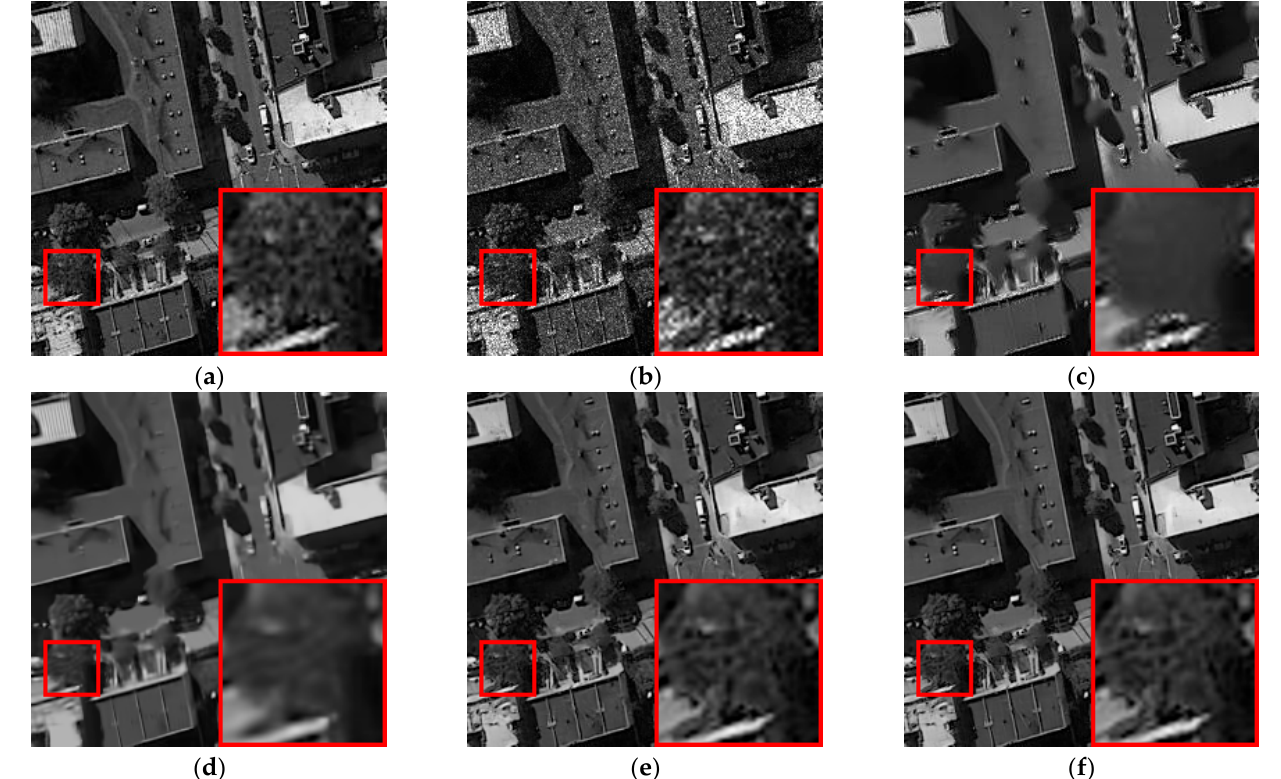
Figure 9. Filtered images of different methods for medium residential test image contaminated by four-look speckle. ( a ) Original image, ( b ) noisy image, ( c ) PPB, ( d ) SAR-BM3D, ( e ) ID-CNN, ( f ) proposed.